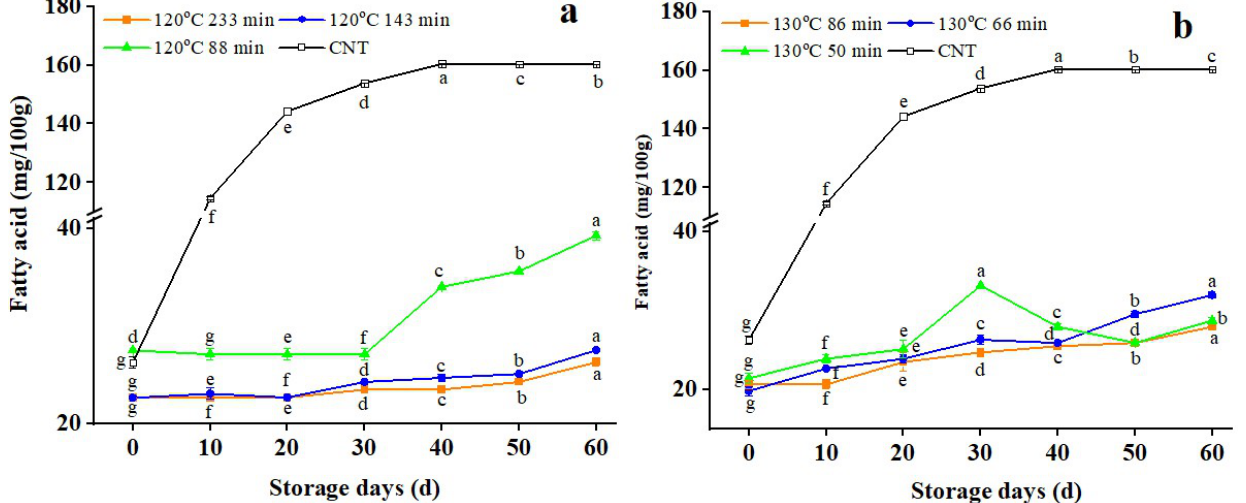
Figure 3. Changes in fatty acid values of rice bran after dry-heated treatment. Note: The lowercase letters refer to the significant difference of the same sample for different storage periods at the same temperature and treatment conditions at p < 0.05. CNT: Control.